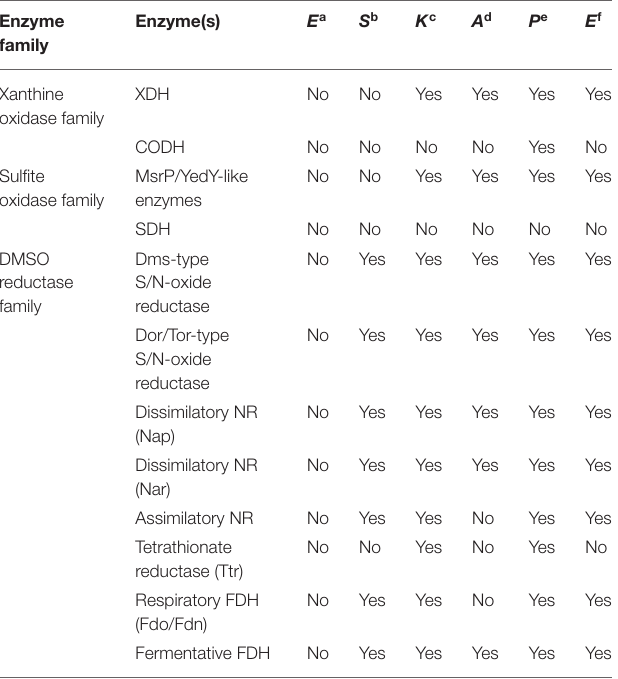
TABLE 2 | Occurrence of mononuclear molybdenum enzymes in ESKAPE pathogens. Enzyme family